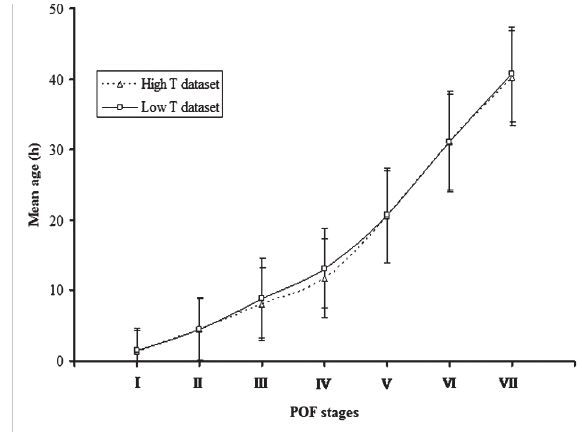
Fig . 2. – PoF incidence-time analysis for the total of anchovy fe- Fig . 5. – Mean ages in hours of PoF stages obtained from the low males analysed (% of occurrence) during two hourly daytime inter- and high water temperature sets of samples. Vertical bars corre- vals. n represents the number of females examined at each daytime spond to one standard deviation of data of PoF ages in interval.